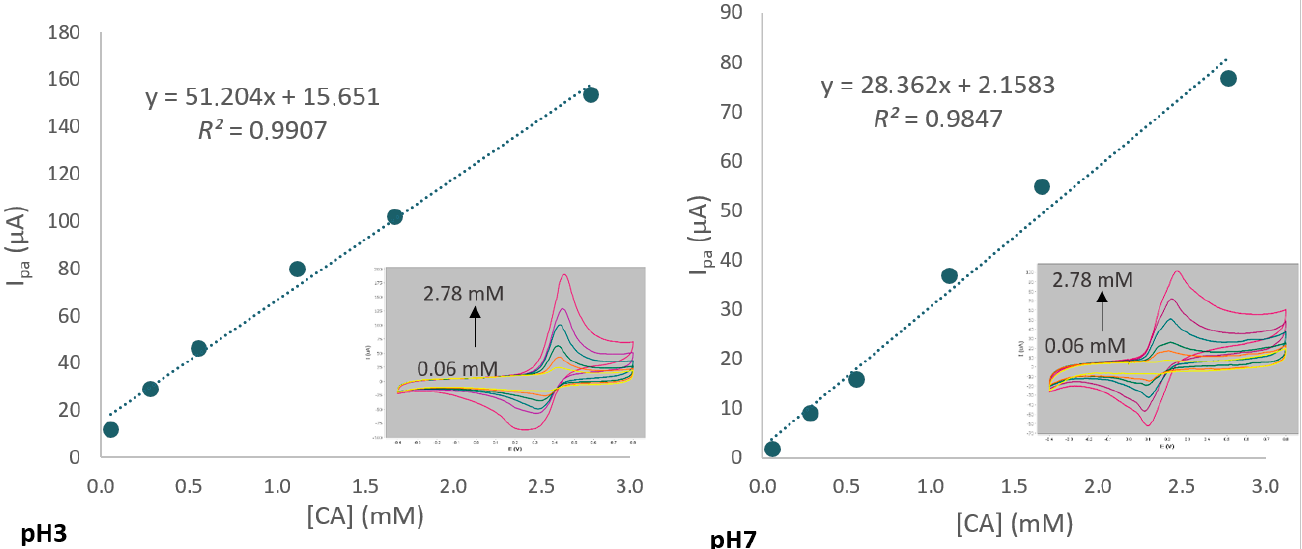
Figure 2. Calibration curves for caffeic acid (CA) in PBS 0.05 M/EtOH (90/10, v / v ) solution, at pH 3 (left) and pH 7 (right). Inset: CV for caffeic acid at different concentrations, ranging from 0.06 to 2.78 mM of CA. The critical value of Pearson’s correlation coefficient is 0.974 for 6 points (degrees of freedom: 4) and a level of significance for a two-tailed test of 0.1%.